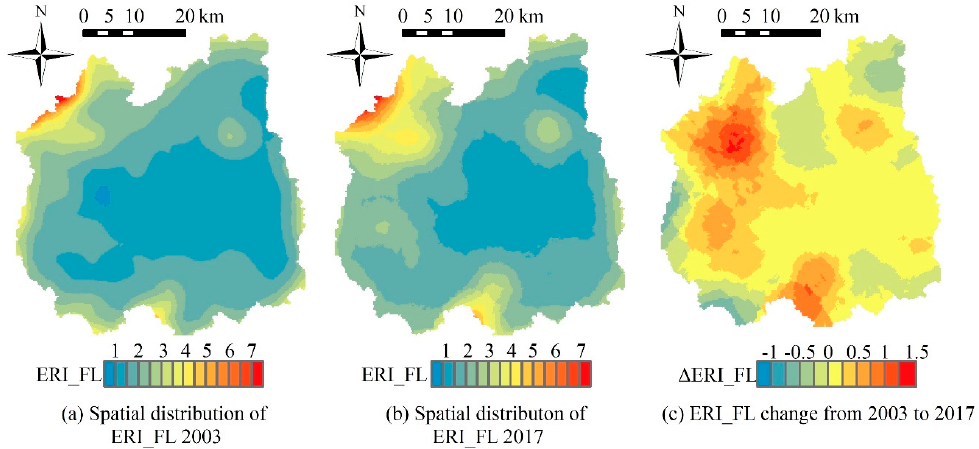
Figure 8. Spatial distributions of ERI_FL for 2003 and 2017, and ERI_FL change from 2003 to 2017.